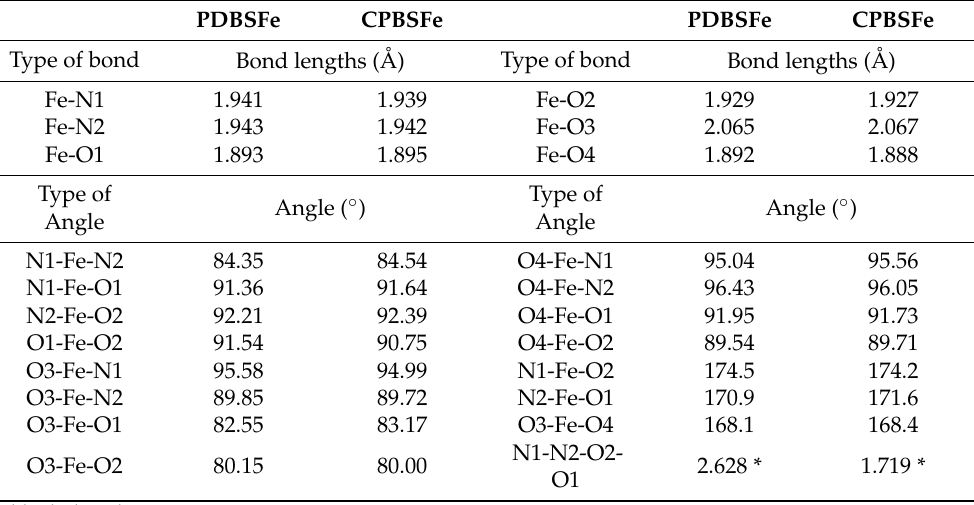
Table 4. Important adjusted bond lengths (Å) and bond angles ( ◦ ) of [FePDBS(H 2 O)NO 3 ]